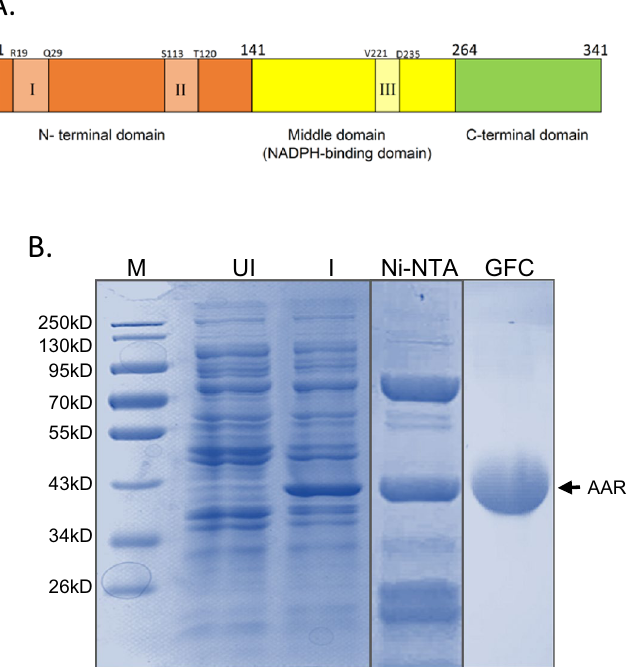
Figure 1. ( A ) Domain organization of AAR. I, II, III represents intrinsic flexible regions in the respective domains. ( B ) Expression and purification of AAR. 12% SDS PAGE showing expression of AAR in E. coli cells. Lane M, medium-range protein molecular weight marker; Lane UI, uninduced M15 (pQE30 AAR) E. coli cells; Lane I, Induced M15 (pQE30AAR) cells; Lane Ni–NTA, Ni–NTA chromatography purified AAR; Lane GFC, GFC purified and concentrated AAR. The represented lanes here are extracted from full gel images shown in Figure